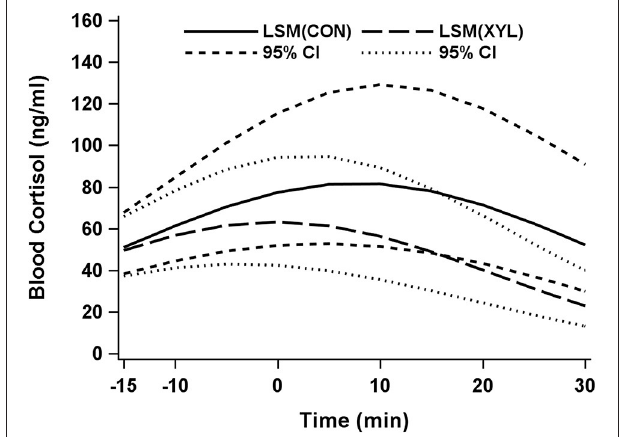
FIGURE 4 | Least Square Means (LSM) curves (polynomial regression) with 95% CI of the groups (XYL, CON) for the blood cortisol concentrations estimated with observations on 10 sheep ( n 5). The sheep were placed in = the chute and the XYL group was injected with 0.1 mg/kg body mass xylazine hydrochloride ( 15min), brought into dorsal recumbency ( 10min), hoof − − trimmed (0min), tilted back (10min), left to stand in the chute (20min), and brought back to their box